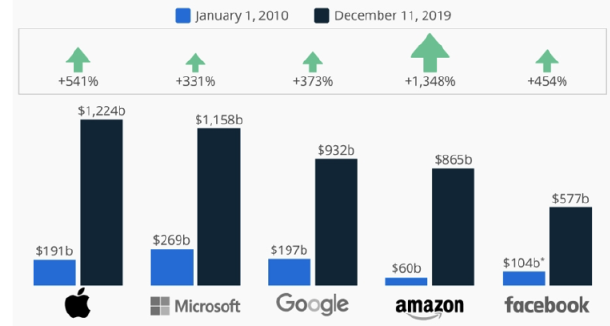
Figure 2: Market capitalization of GAFAM at the beginning of 2010 and at the end of 2019; Source: (Statista,